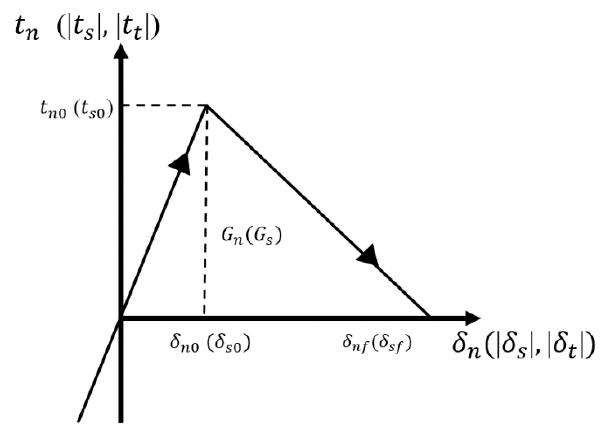
Figure 5. Stress–displacement relationship in a single direction.